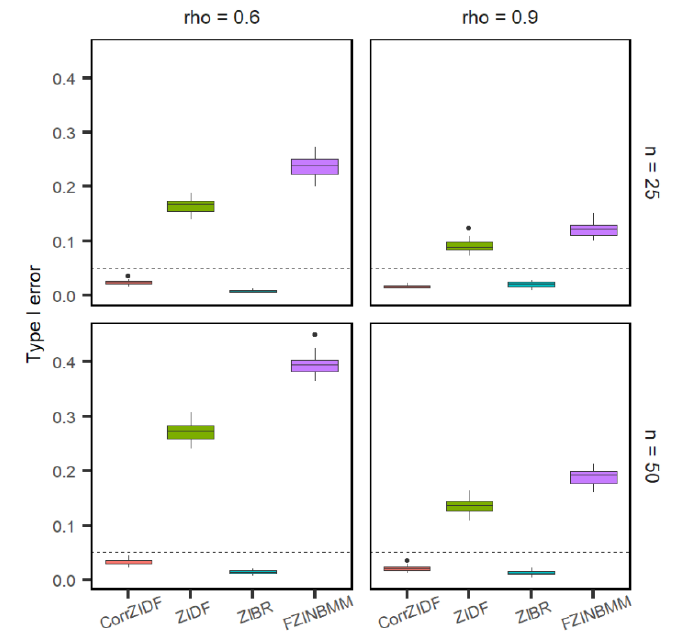
Figure 2. Boxplots of Type I error rates under various settings based on 20 replicated simulations with 1000 features (including 200 DAFs) after adjusting multiple comparisons. The dashed line represents the cutoff of 0.05. Assume AR (1) correlation structure across different sampling points. The p -values are adjusted by the BH procedure.